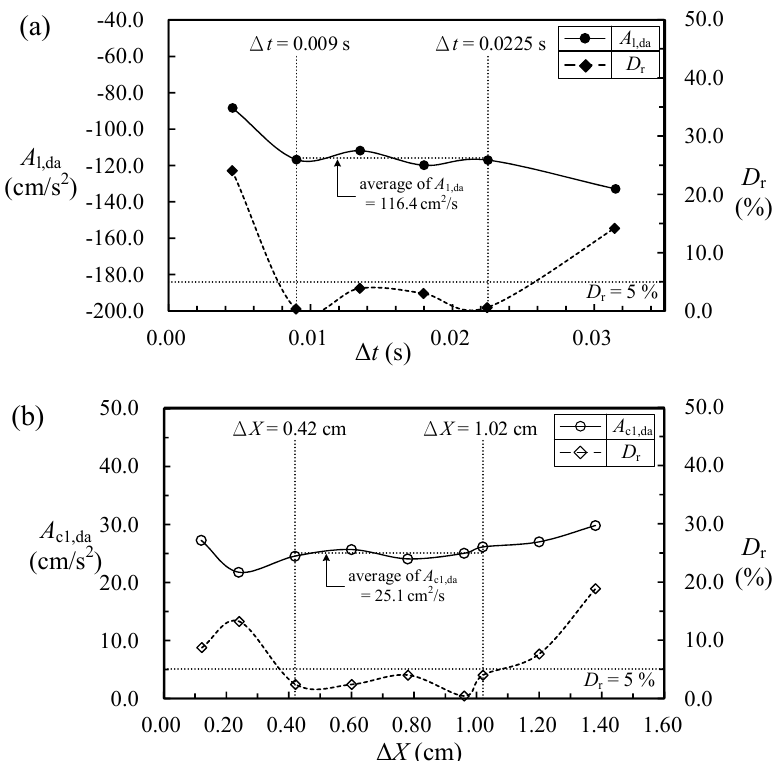
Figure 5. The calculation results and relative deviations for the partially depth-averaged values of ( a ) the local acceleration A l,da corresponding to different time intervals Δ t used; and ( b ) the first convective acceleration A cl,da corresponding to distinct spatial intervals Δ X employed at t = 0.6545 s. The promising range of Δ t or Δ X , within which the relative deviation D r of each result of either A l,da or A cl,da would only vary within 4.0% with respect to the average, is marked between the two dotted vertical lines.